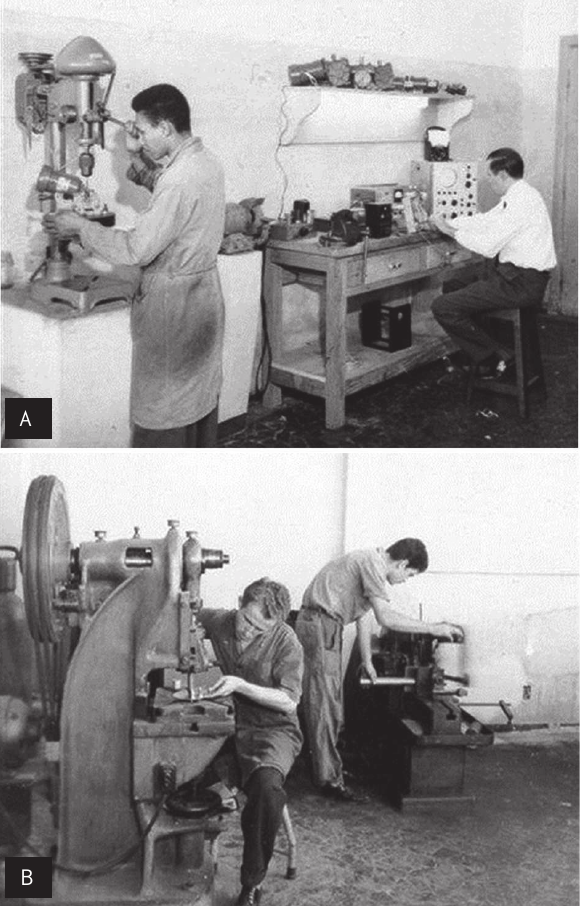
Fig. 5 – Oficina do Coração-Pulmão Artificial - “Porão” HC- USP – São Paulo. Da esq para dir. (a) Benvindo - furadeira, Eng. Nemésio - Eletrônica,; (b) Waldomiro - prensa e Braile na